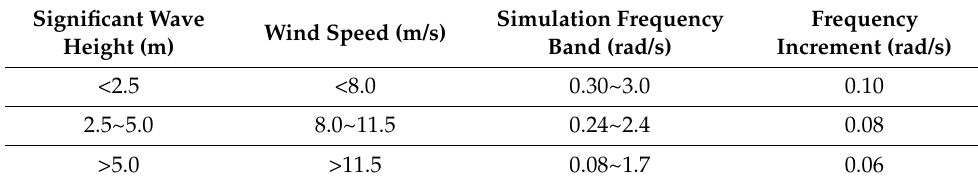
Table 2. The simulation frequency band and frequency increment under different sea states.